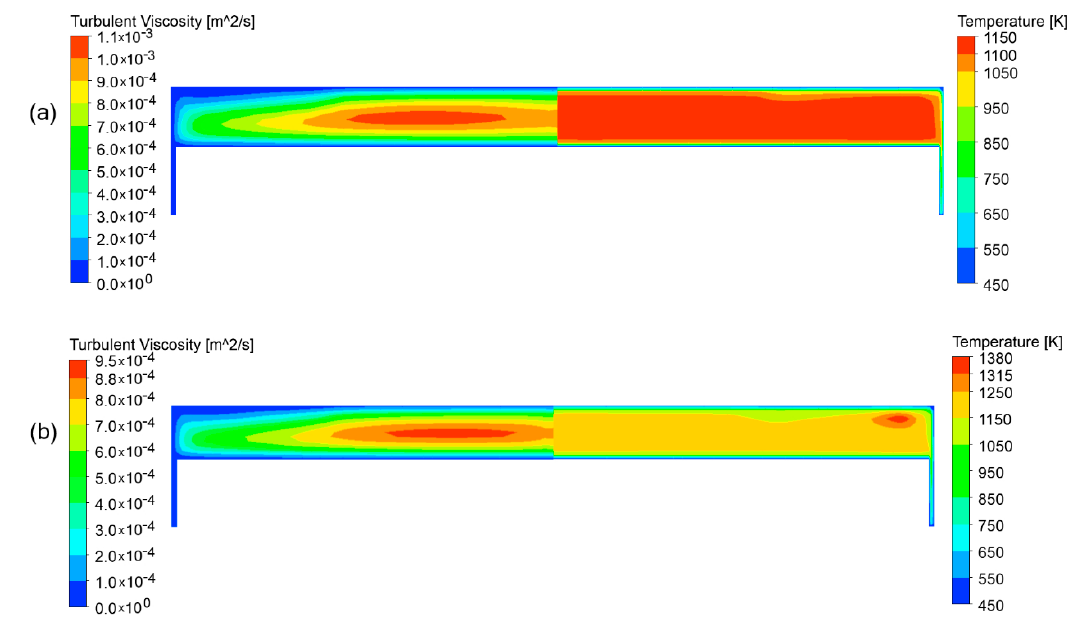
Figure 10. Turbulent diffusivity (left) and temperature (right) distributions at different crank angles for the flat-piston case. ( a ) 9 CAD BTDC; ( b ) 3 CAD BTDC.